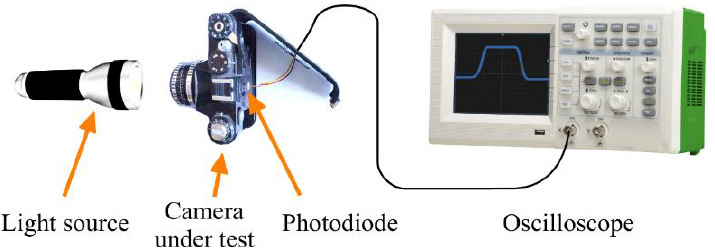
Figure 3. Direct method using a light sensor and an oscilloscope.